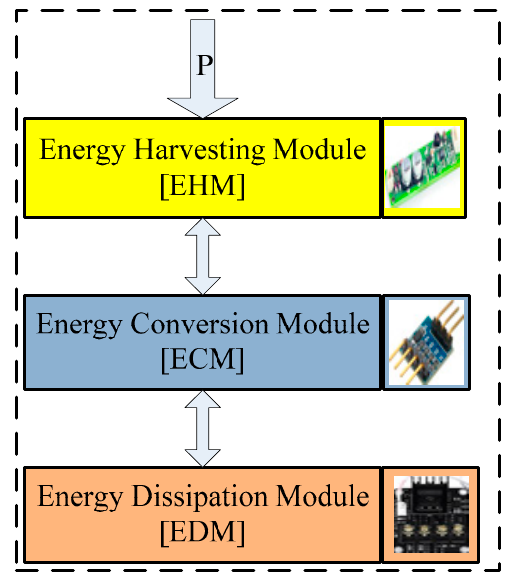
Figure 11. Block diagram of an autonomous harvesting system [75].